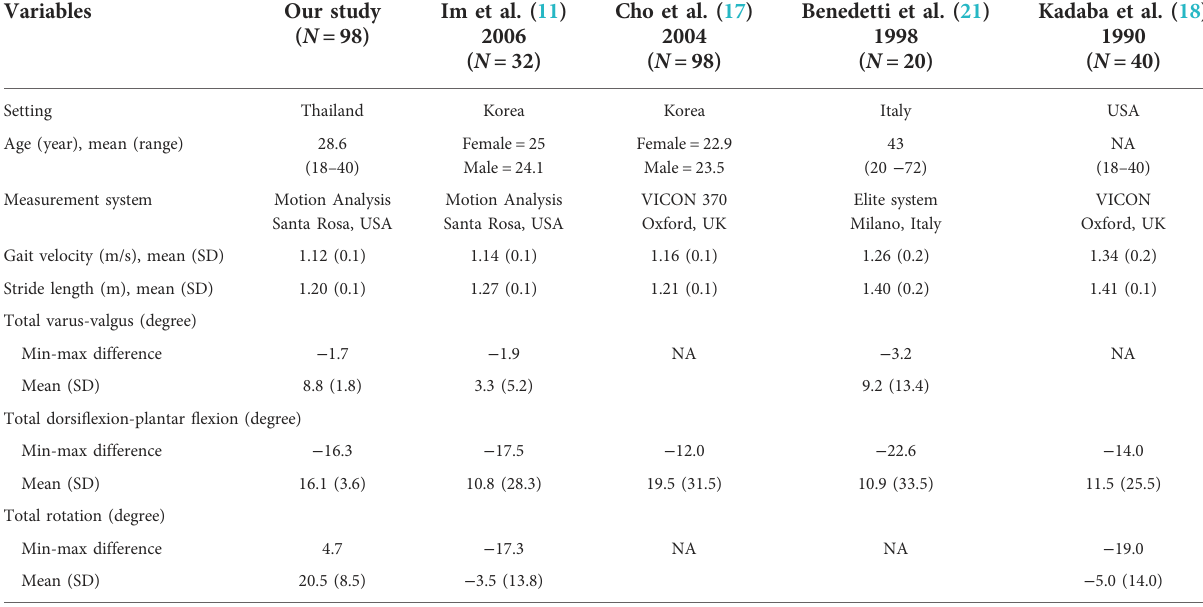
TABLE 5 The comparison of ankle kinematics between